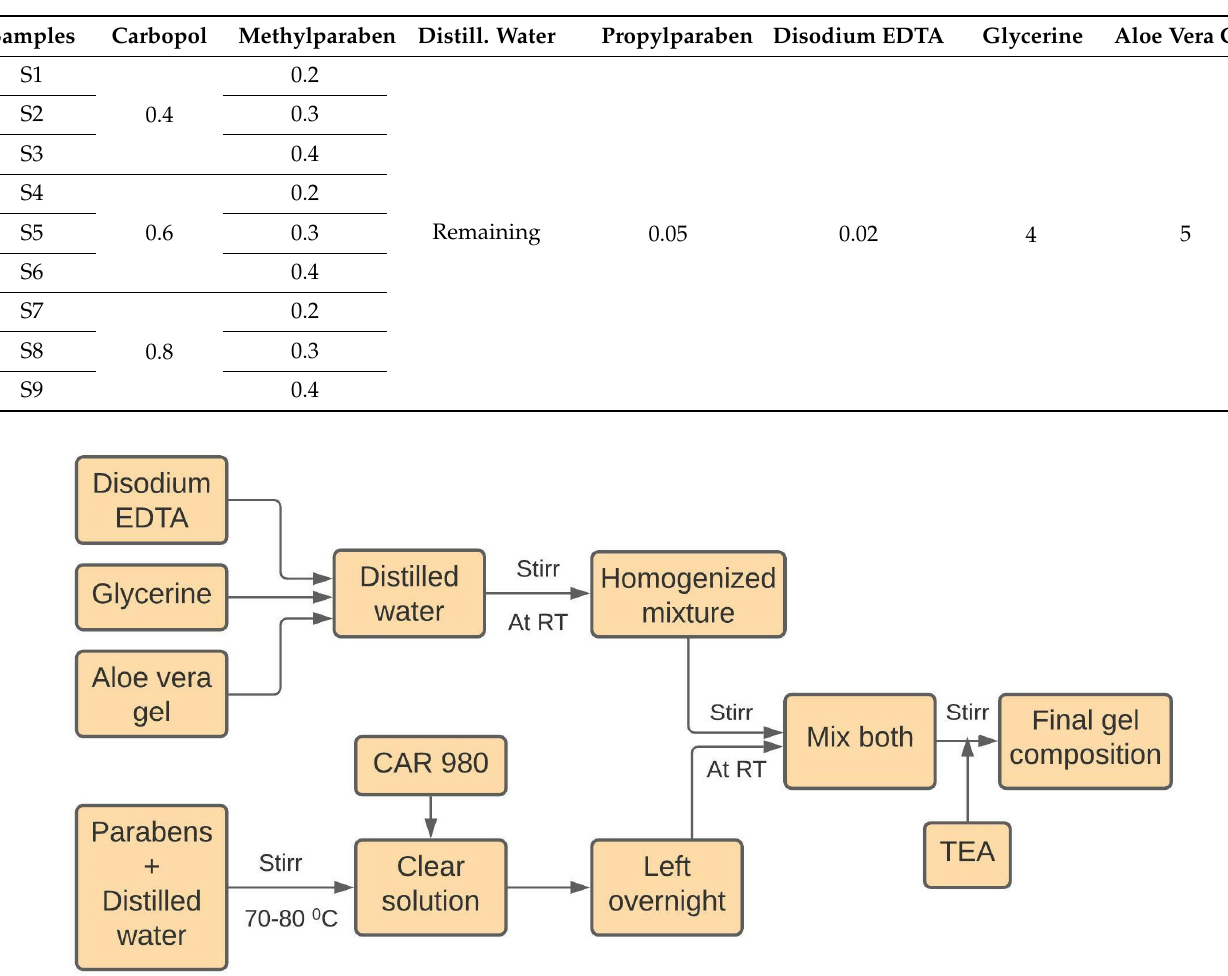
Table 5. Composition of different gel formulations, each concentration is based on w / w % of the total sample (100 g).